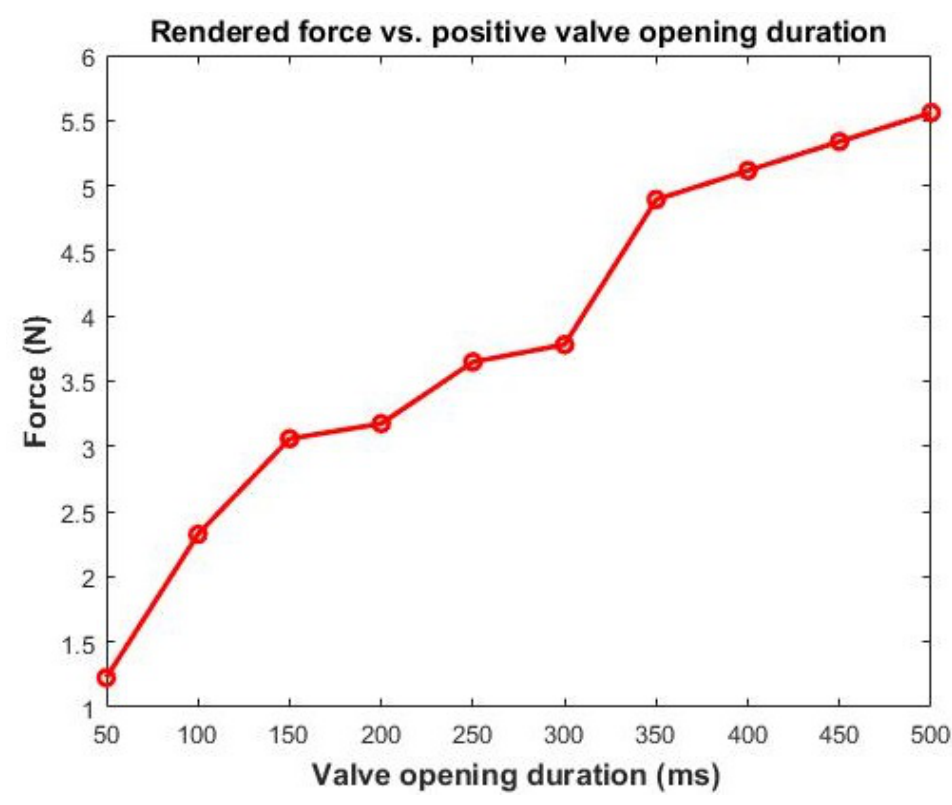
Figure 9. Rendered force vs. positive valve opening